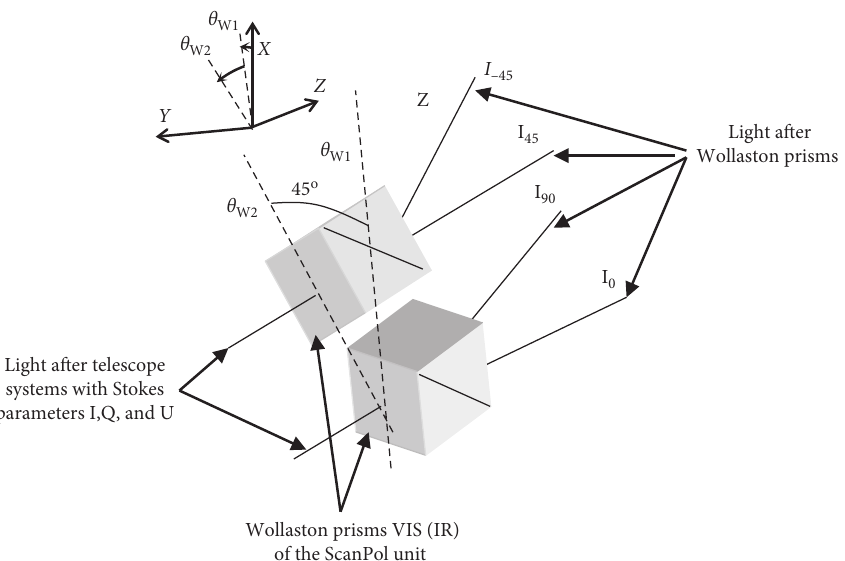
Figure 11: Orientation of the polarizing axes of Wollaston prisms in the ScanPol coordinate